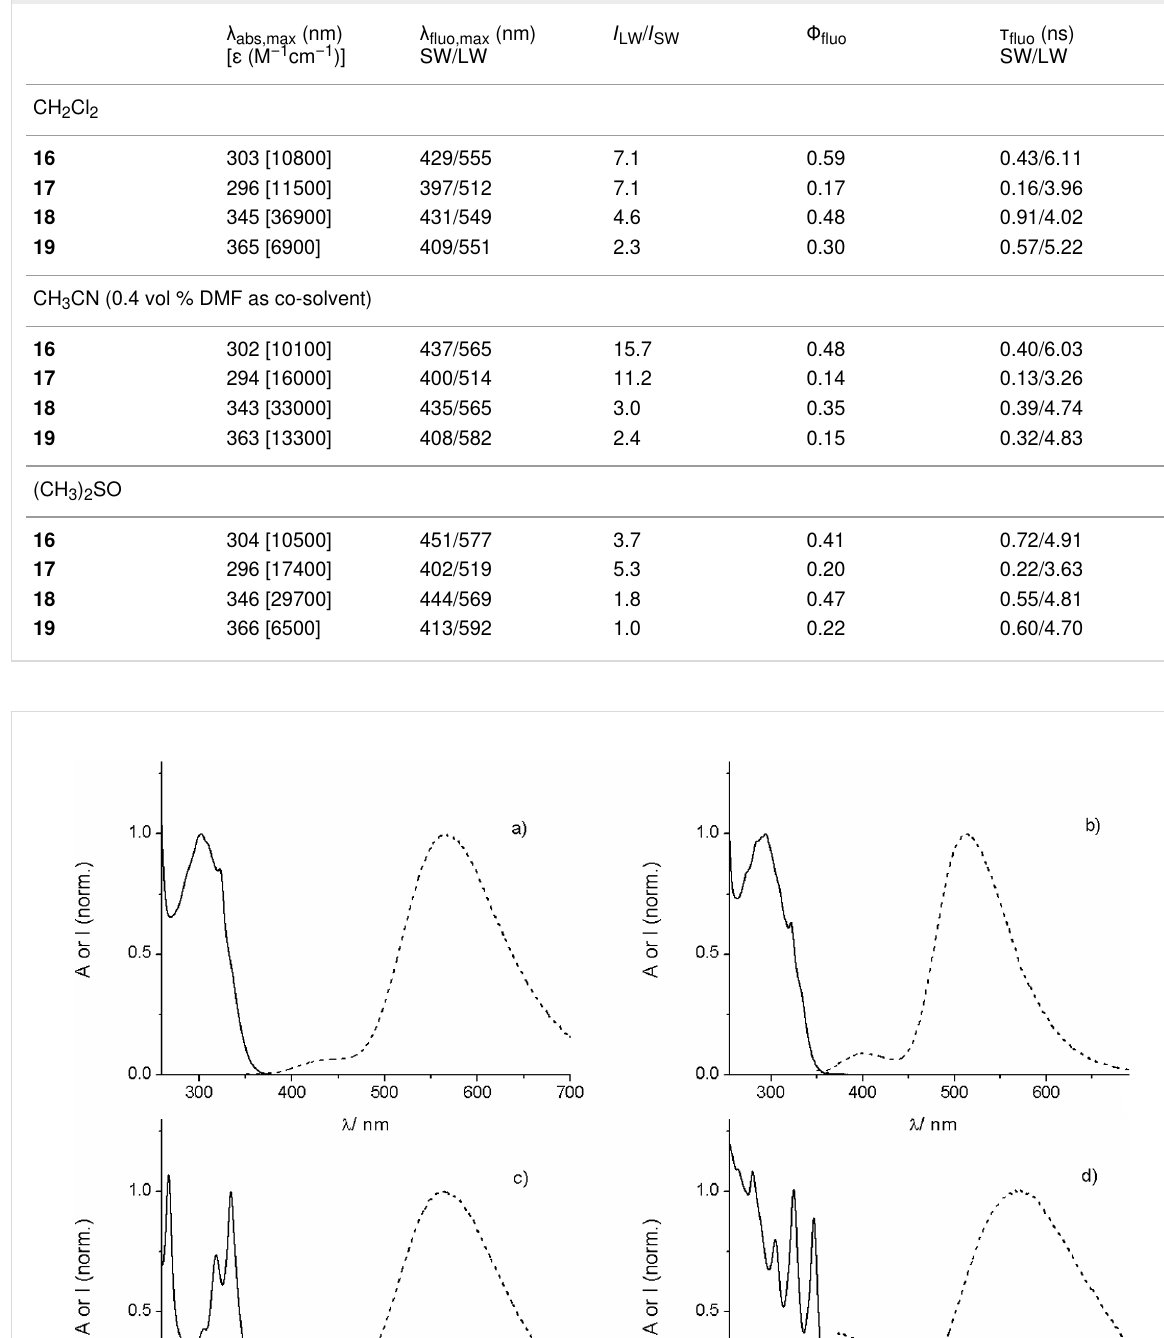
Table 1: UV–vis and fluorescence properties of the dyes 16 – 19 in various solvents.